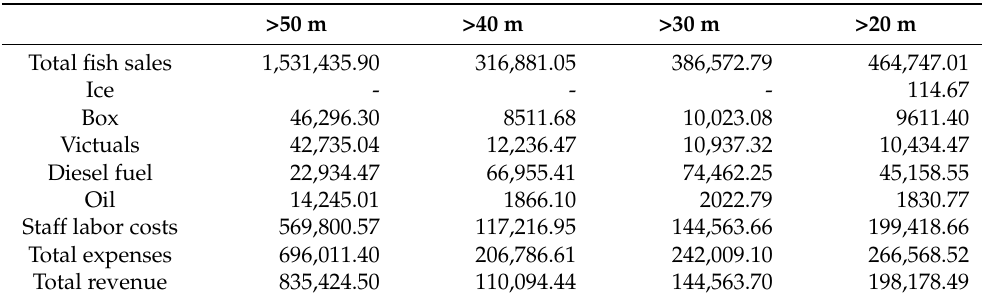
Table 4. Net revenue calculated per vessel owner based on sales and associated costs for 2020 (in USD). Note: 1 United States Dollar = 7.02 TL in